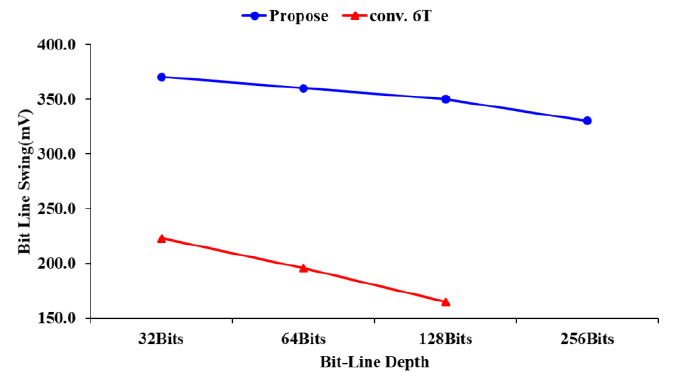
Figure 8. Comparison of bit-line swing at different bit-line depth.